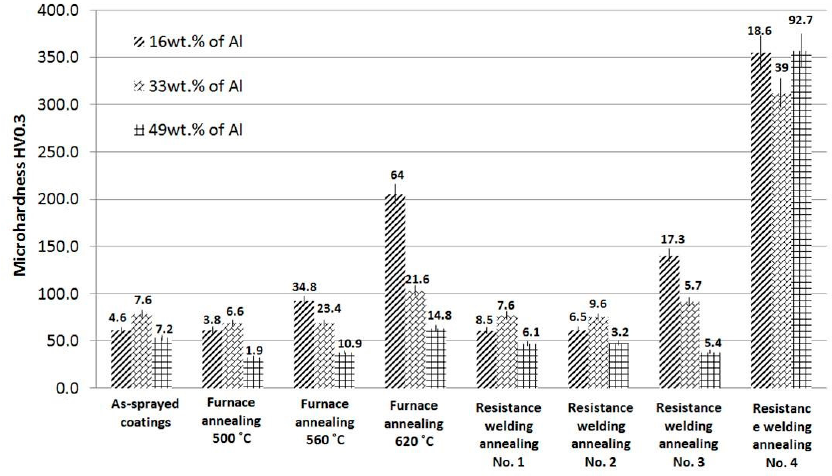
Figure 14. Microhardness of as-sprayed and heat-treated coatings with standard deviation values above posts. above